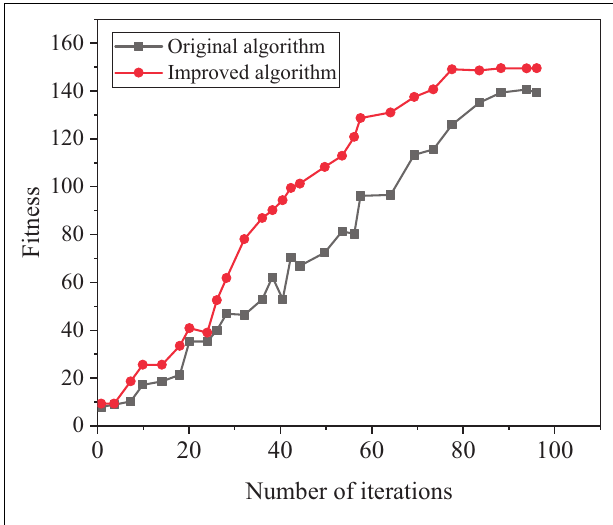
FIGURE 9 | Performance comparison of different algorithms.